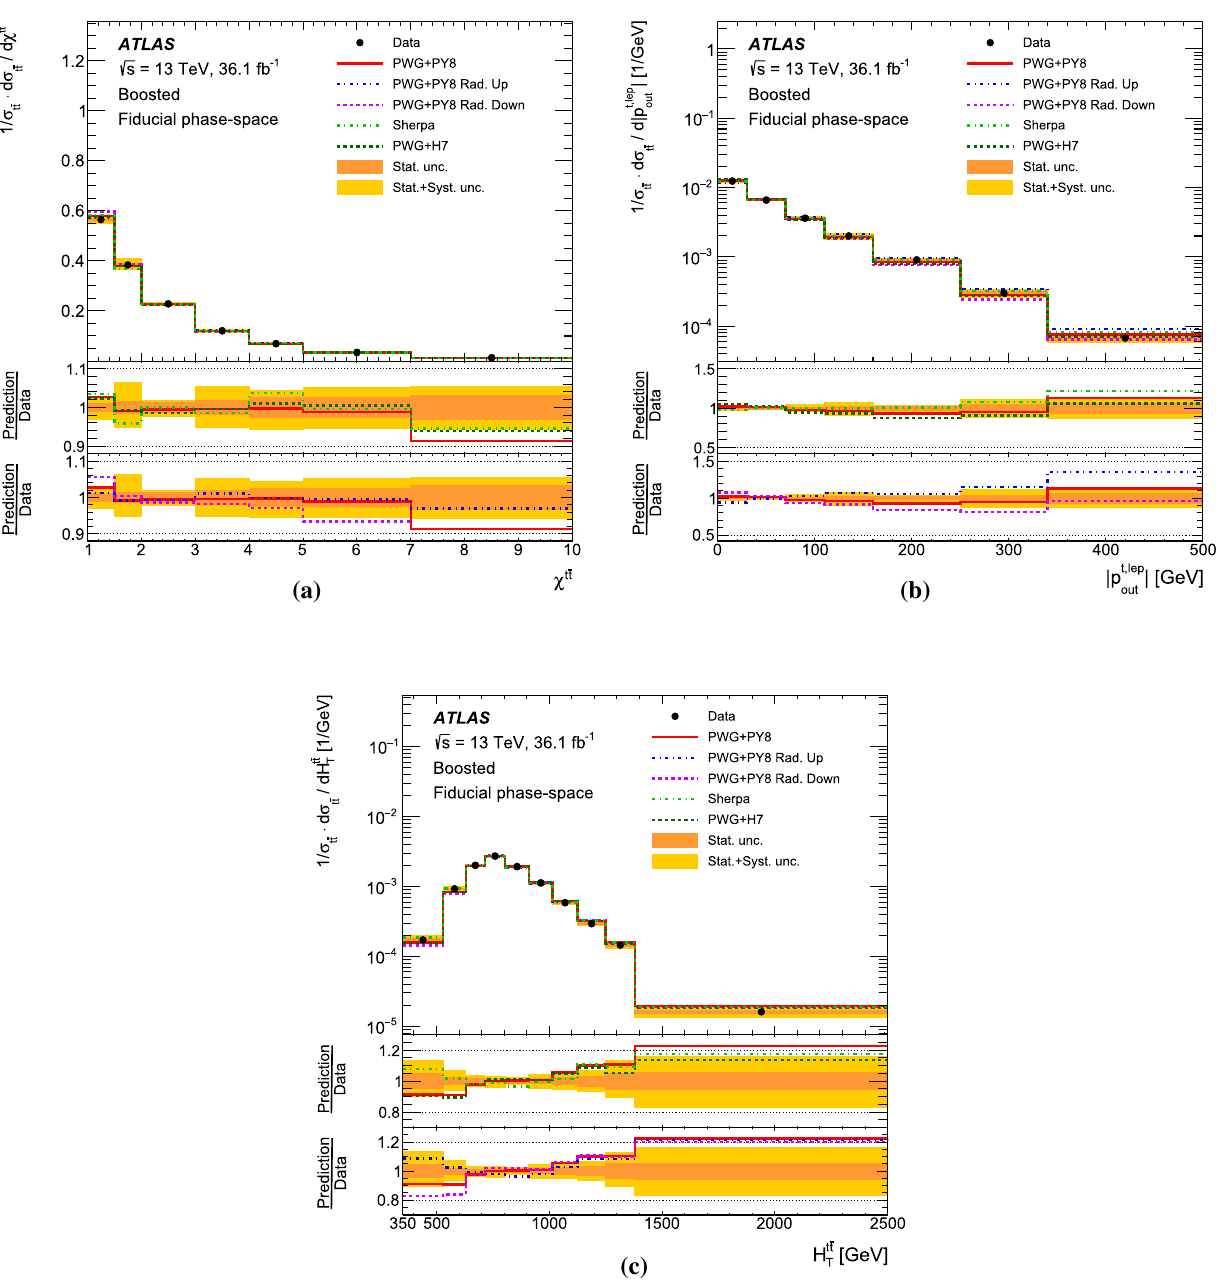
Fig. 41 Particle-level normalised differential cross-sections as a func- (cid:7) (cid:7) (cid:7) and c H t ¯ t (cid:7) p t , lep in the boosted topology, compared tion of a χ t ¯ t , b out T with different Monte Carlo predictions. The bands represent the statisti-